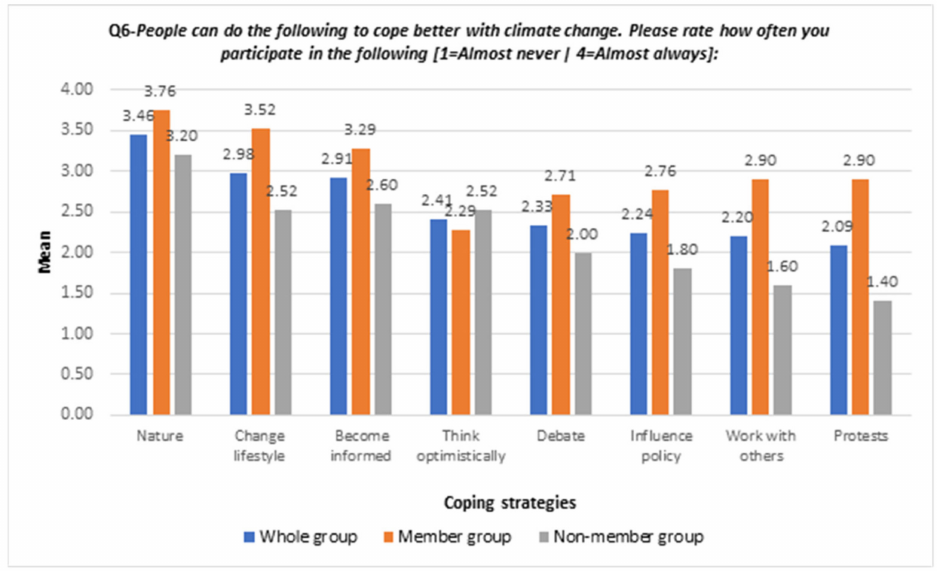
Figure 4. Bar chart of use of coping strategies between groups—whole sample and between